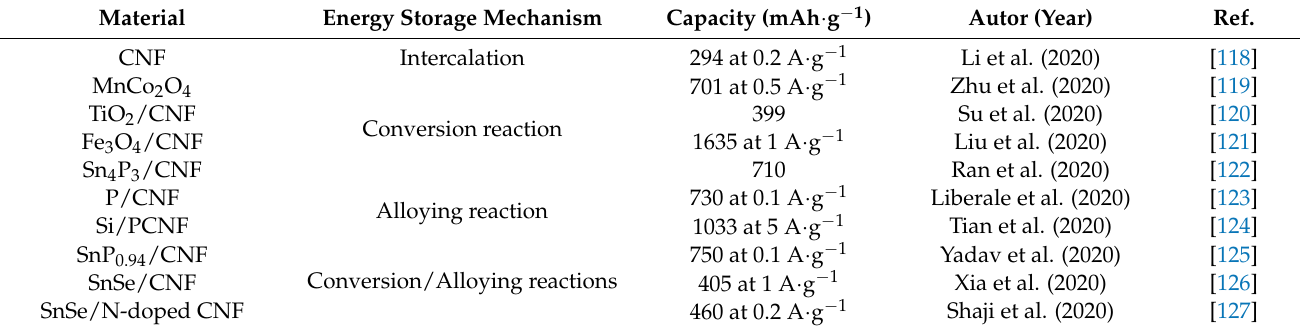
Table 2. Summarization of some of the most recent approaches toward fabrication of nanofibrous anodes.